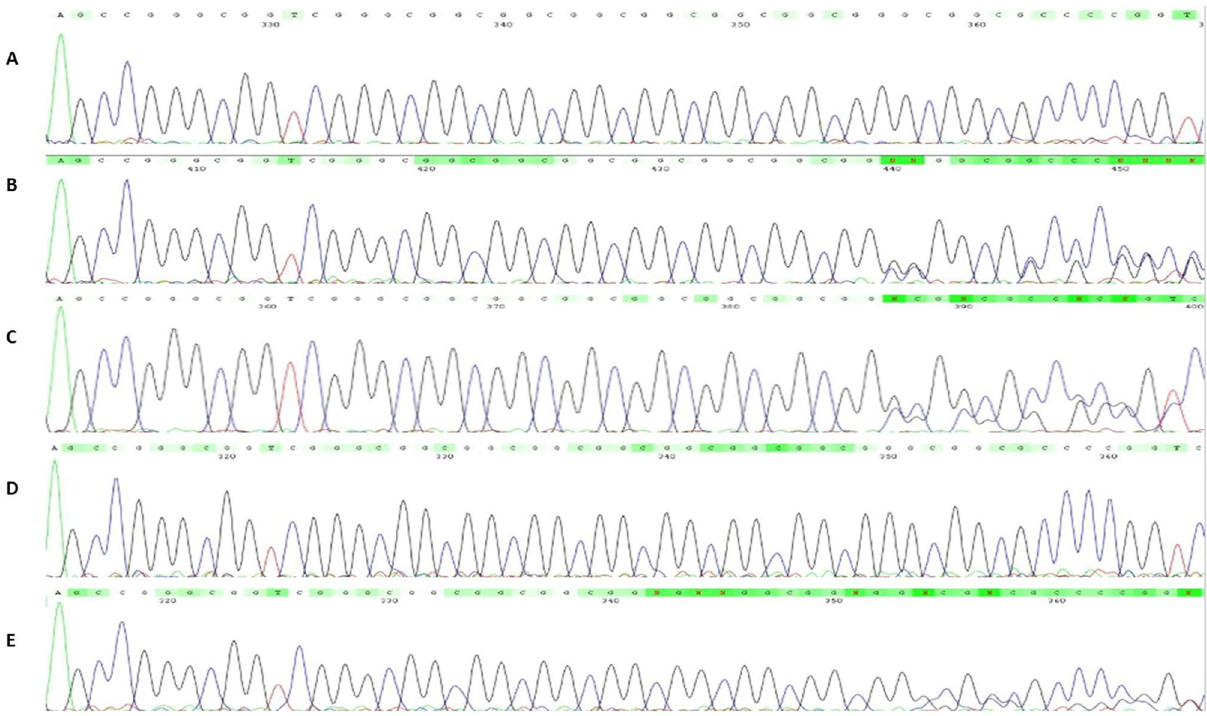
Figure 4. Electropherogram of the non-6 genotypes (divergent genotypes) at the RASGEF1C (GGC) in NCD patients. ( A ) 7/7, ( B ) 7/8, ( C ) 7/9, ( D ) 8/8, ( E ) 8/11.